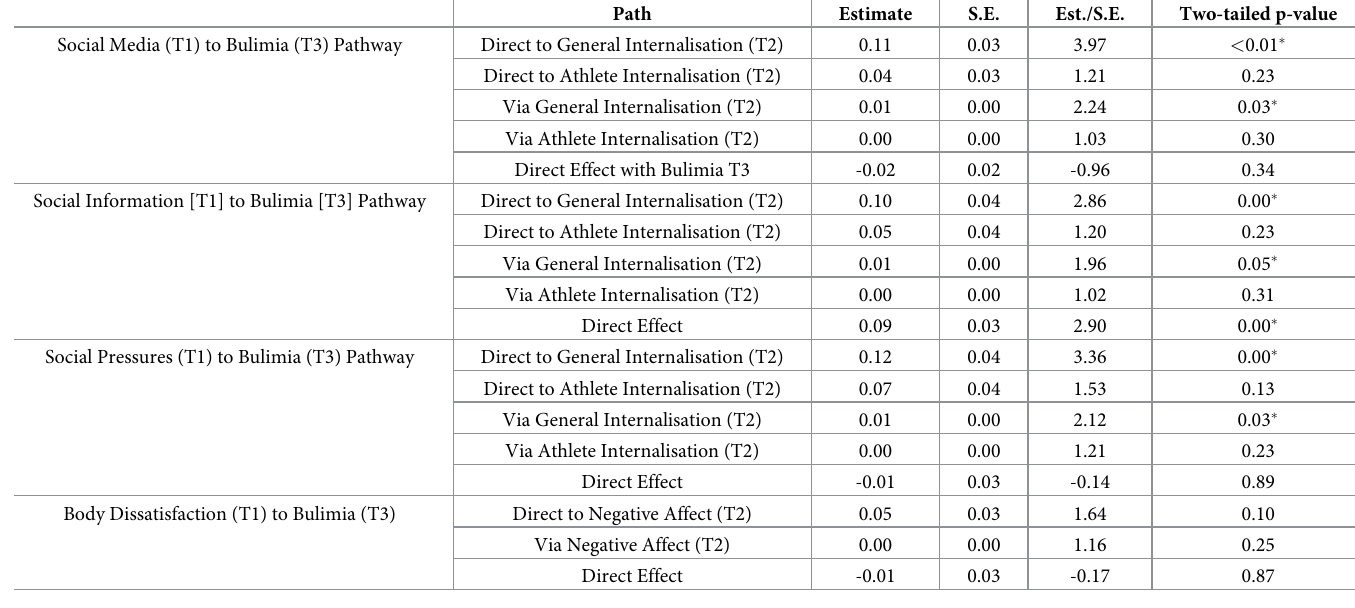
Table 8. Indirect and direct effects (model